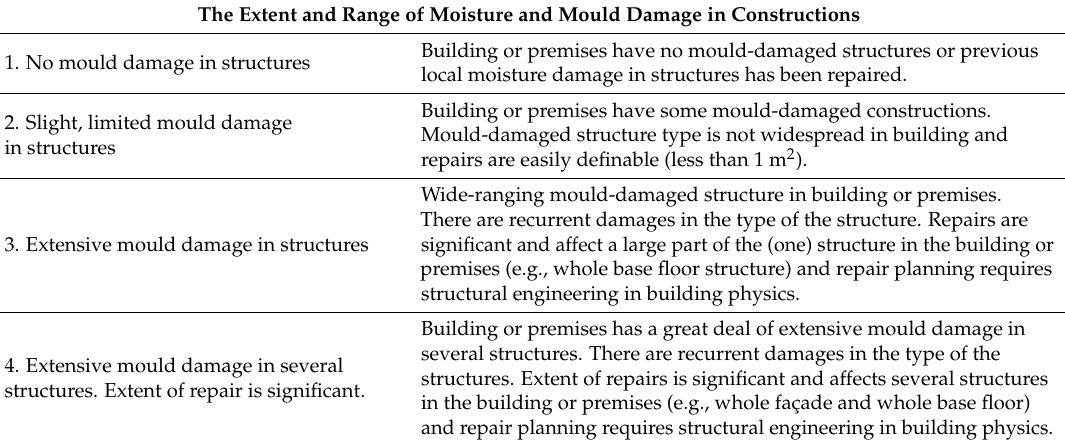
Table 1. Main criteria for assessing the extent and range of moisture and mould damage in constructions.